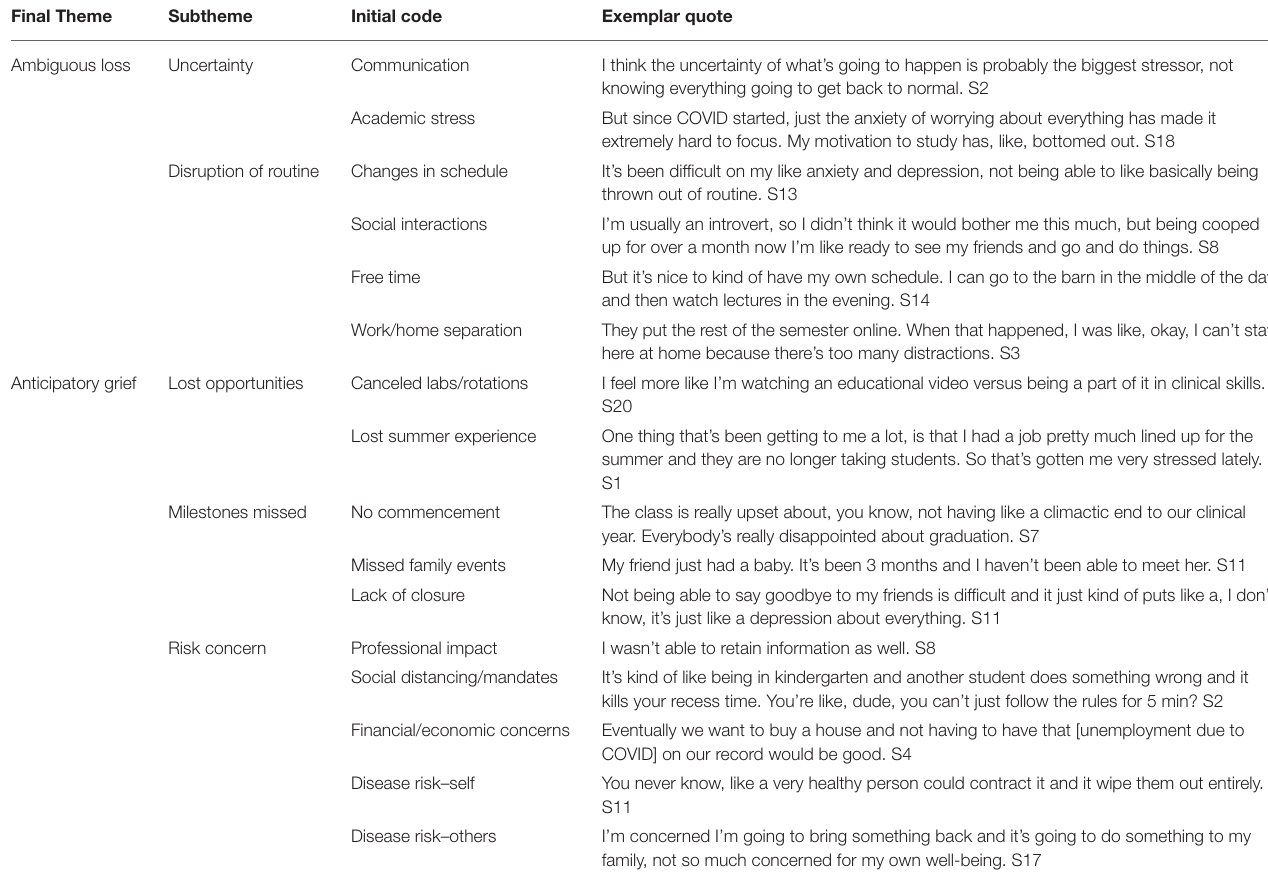
TABLE 2 | Themes and coding exemplars. Final